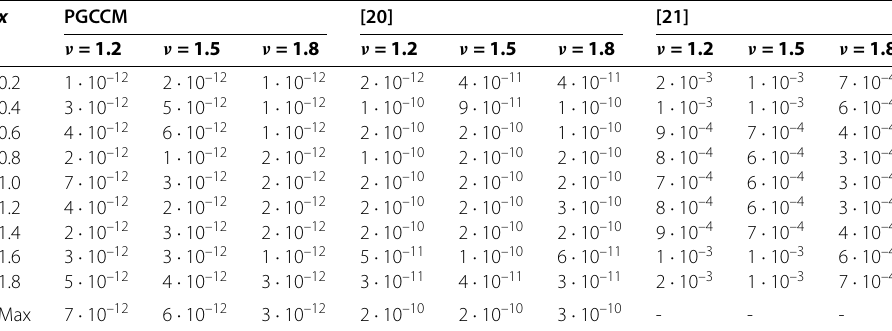
Table 6 Comparison between different errors of Example 4 for the case M = 9